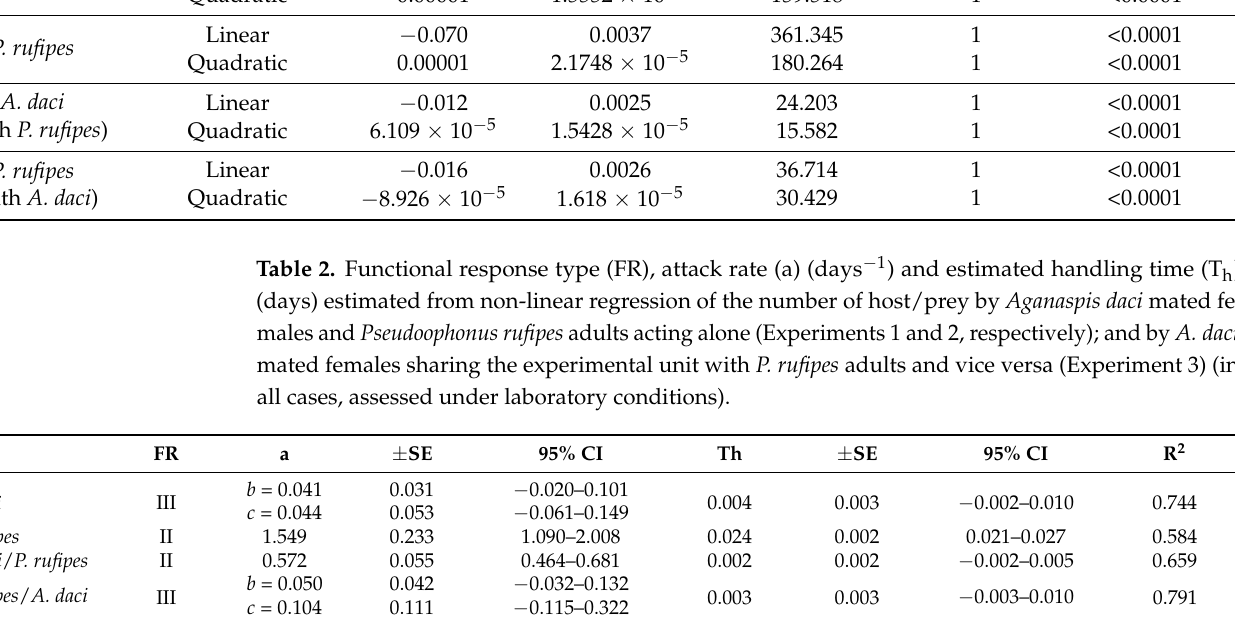
R 2 = are the coefficients of determination from R 2 of each regression.